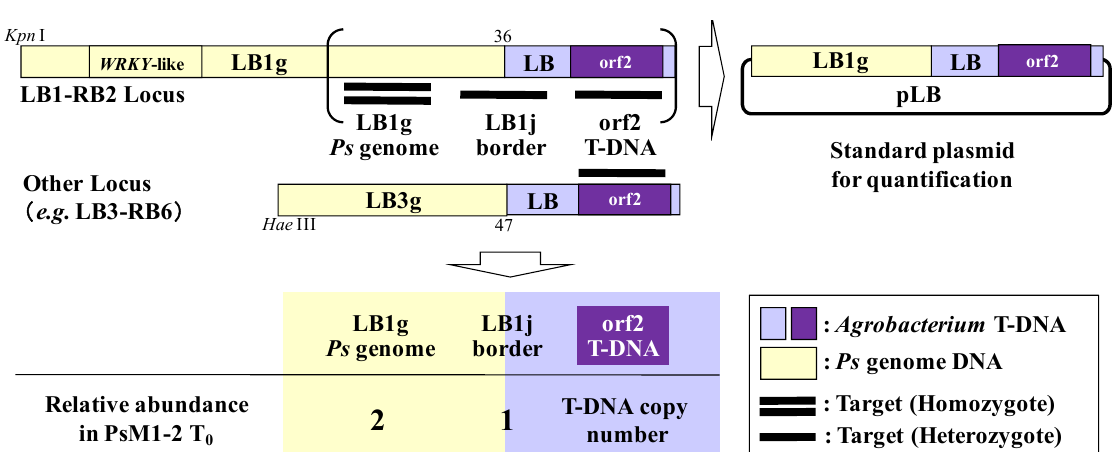
Figure 9. Schematic diagram of the strategy of T-DNA copy number analysis by real-time PCR.